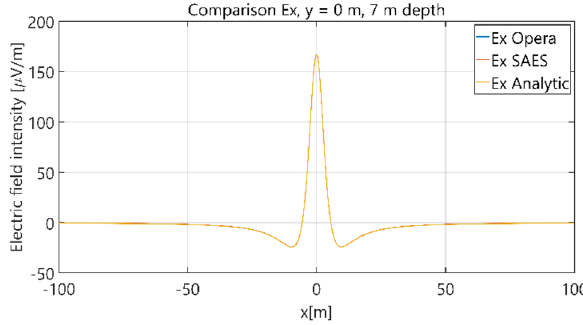
Figure 10. Distribution of E x component ( y = 0 m, z = − 7 m, case I).